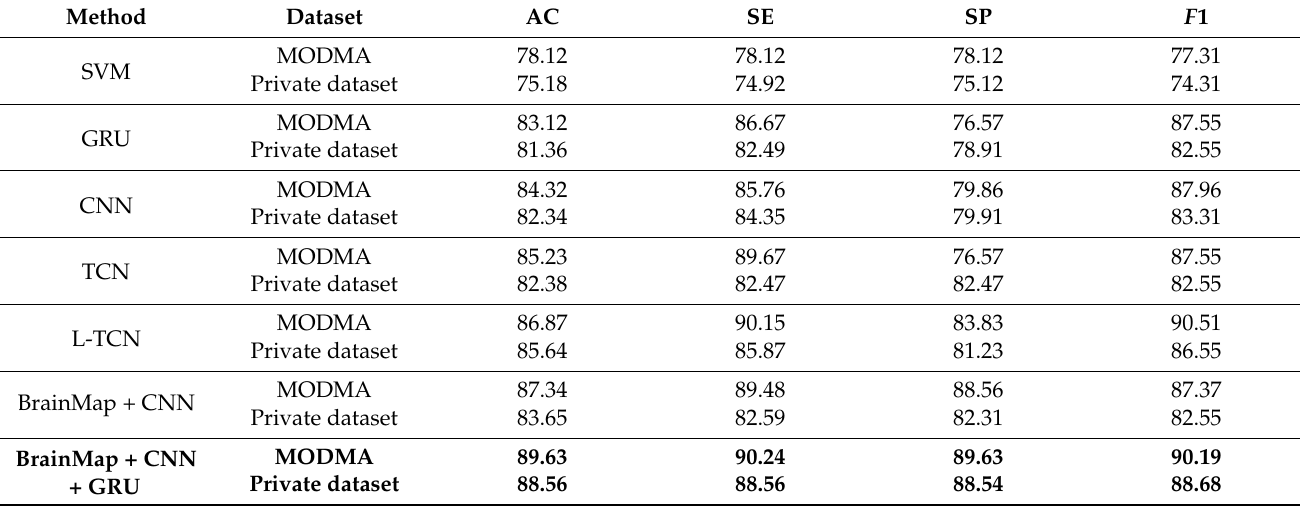
Table 5. Comparison of the classification results between difference